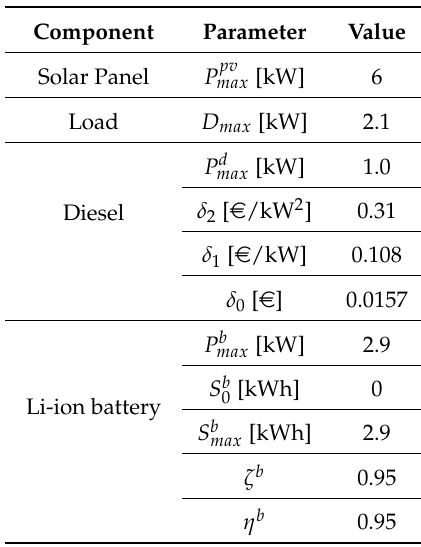
Table 1. Microgrid